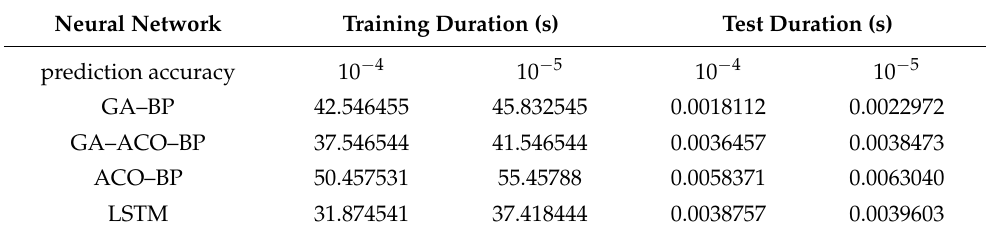
Table 5. Model efficiency comparison table (YueYang/curved channel).